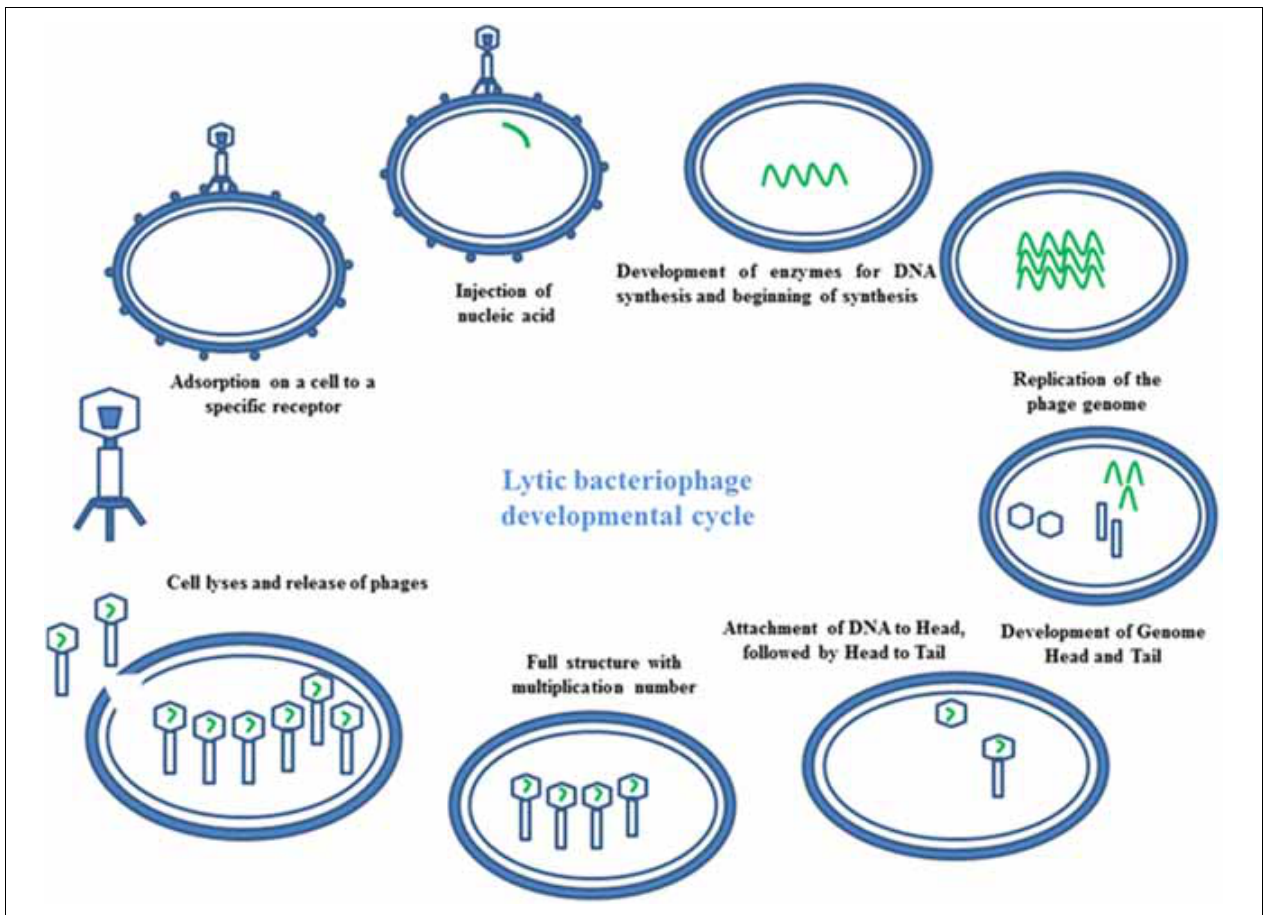
FIGURE 3 | Mechanism of phage therapy. Image represents the schematic diagram of developmental cycle of lytic bacteriophage.